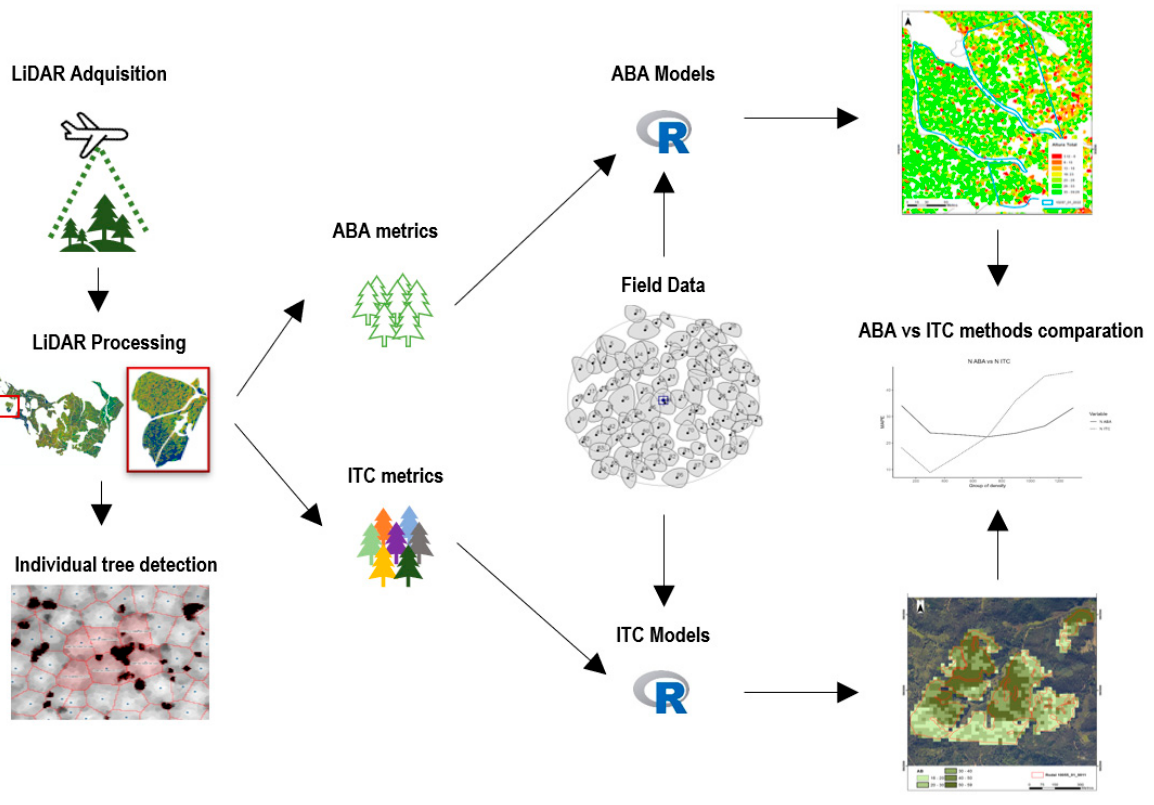
Figure 2. Overview of the proposed workflow used to compare the performance of the ABA and ITC approaches for predicting forest inventory